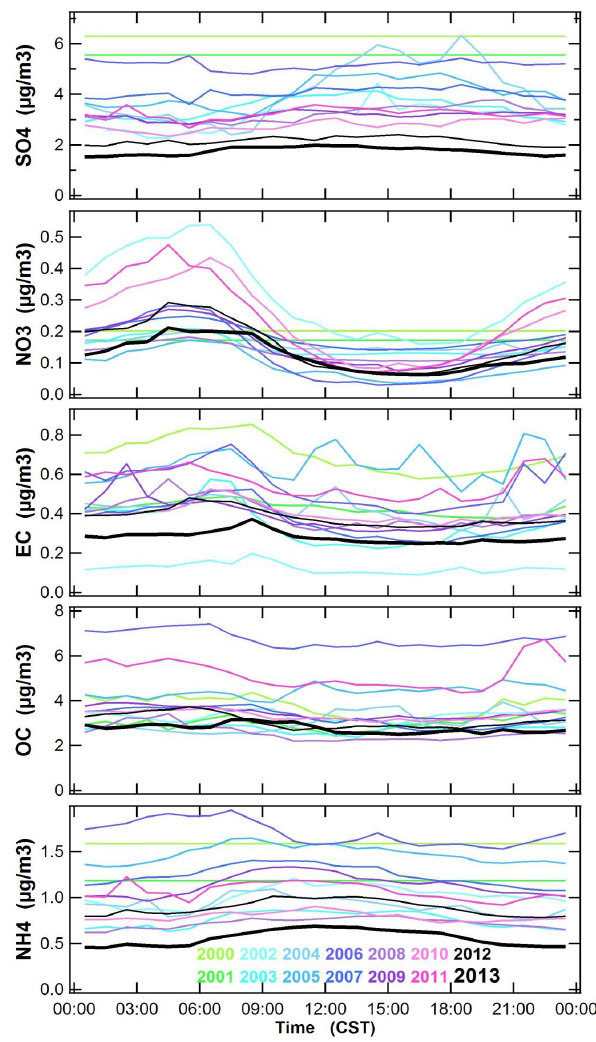
Figure 15. Mean diurnal concentrations of PM 2 . 5 SO 4 , p NO 3 , EC, OC, and NH 4 at CTR from 1 June through 15 July each year. For 2000–2001, SO 4 , NO 3 , and NH 4 are 24h